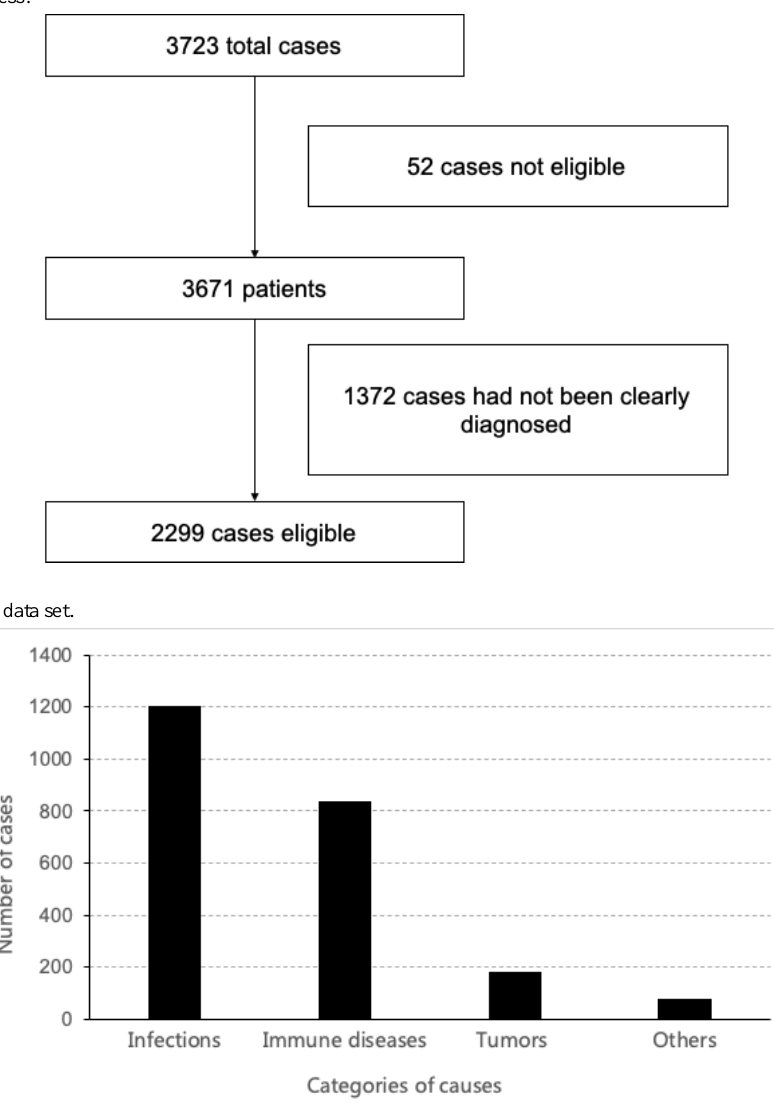
Figure 2. Data filtering process.